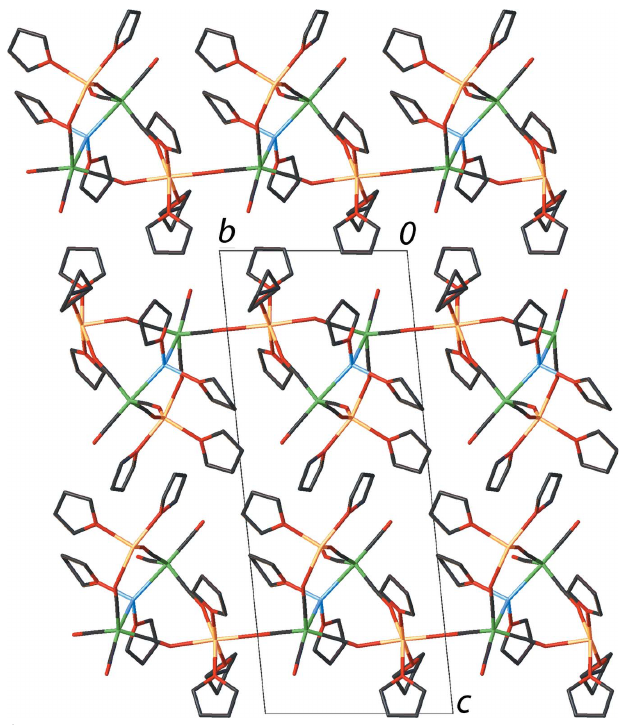
Figure 2 Packing diagram of the title compound, viewed along the a axis, highlighting the stacking of